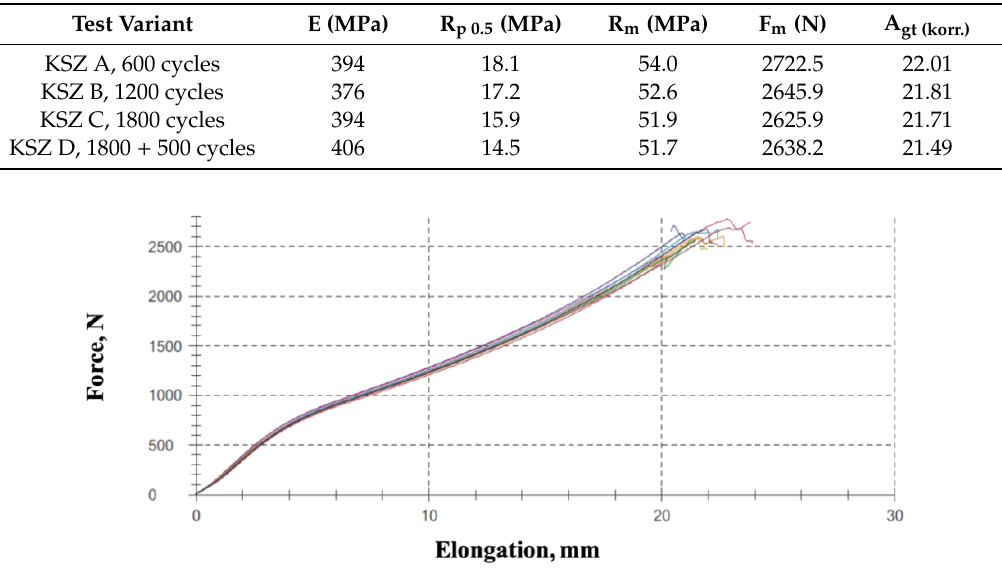
Table 7. Results for mechanical properties (DIN EN 10002-1)—thermal shock chamber (mean values).